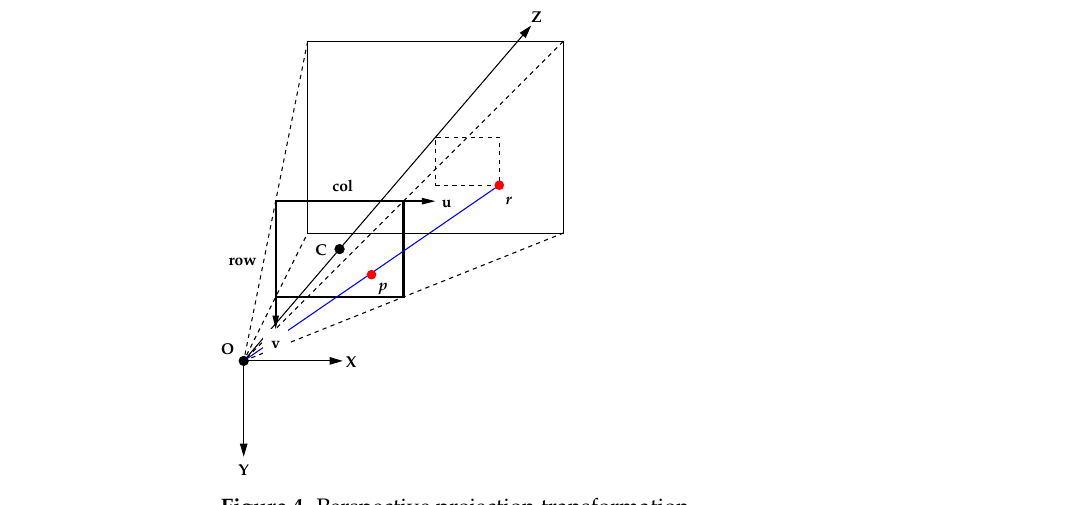
Figure 4. Perspective projection